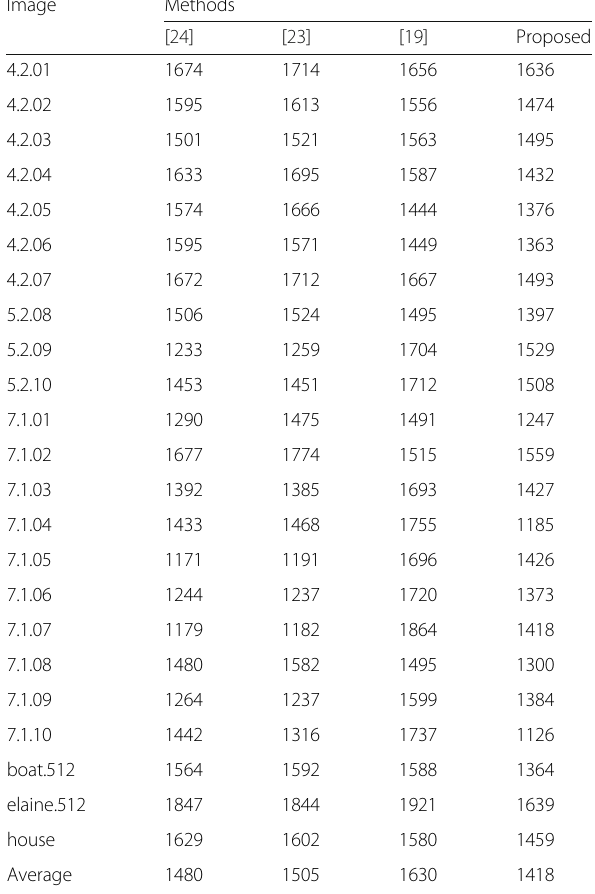
Table 4 Comparison in terms of increasing file size (bytes) on USC-SIPI 23 images with payload size of 10,000 bits Image Methods